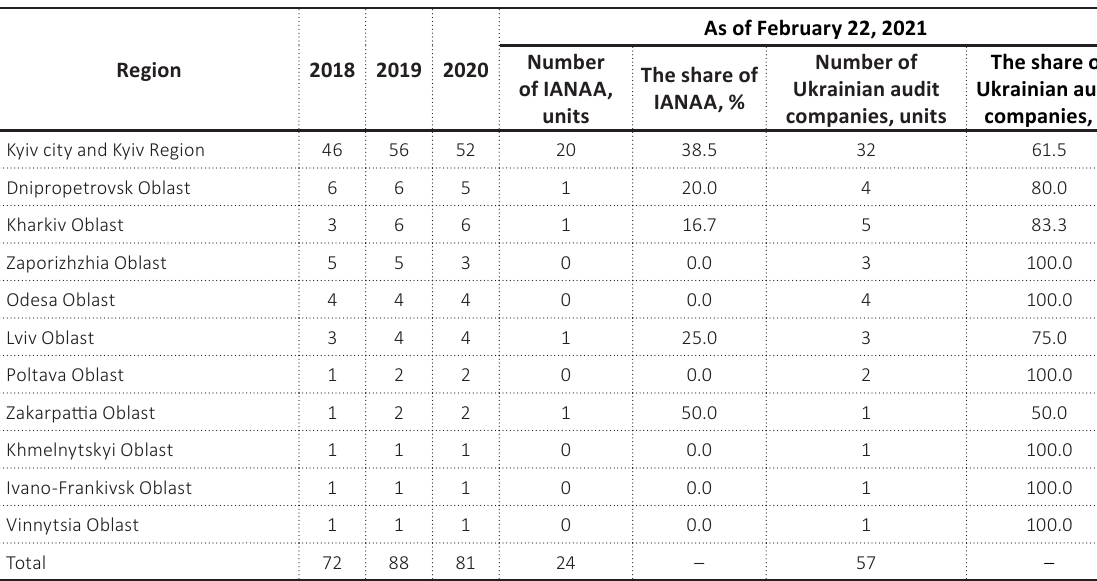
Table 2. Dynamics of audit entities entitled to conduct a statutory audit of the financial statements of public interest companies